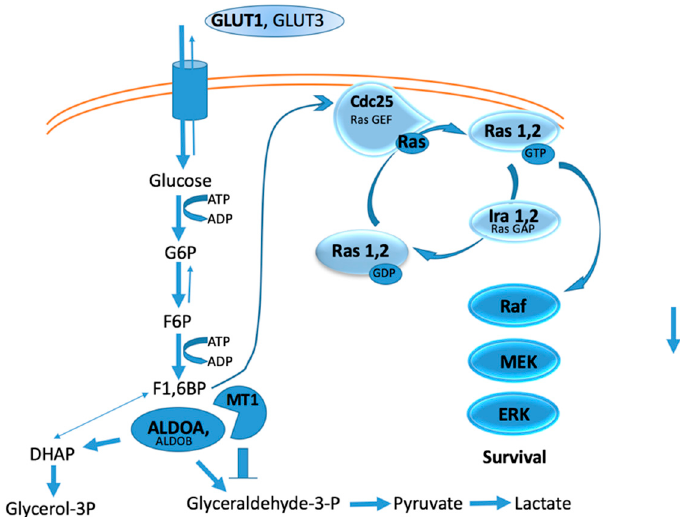
Figure Figure 2. Hypothetical relationship between glycolysis, Ras activation, and MT1-MMP intracellular activity.